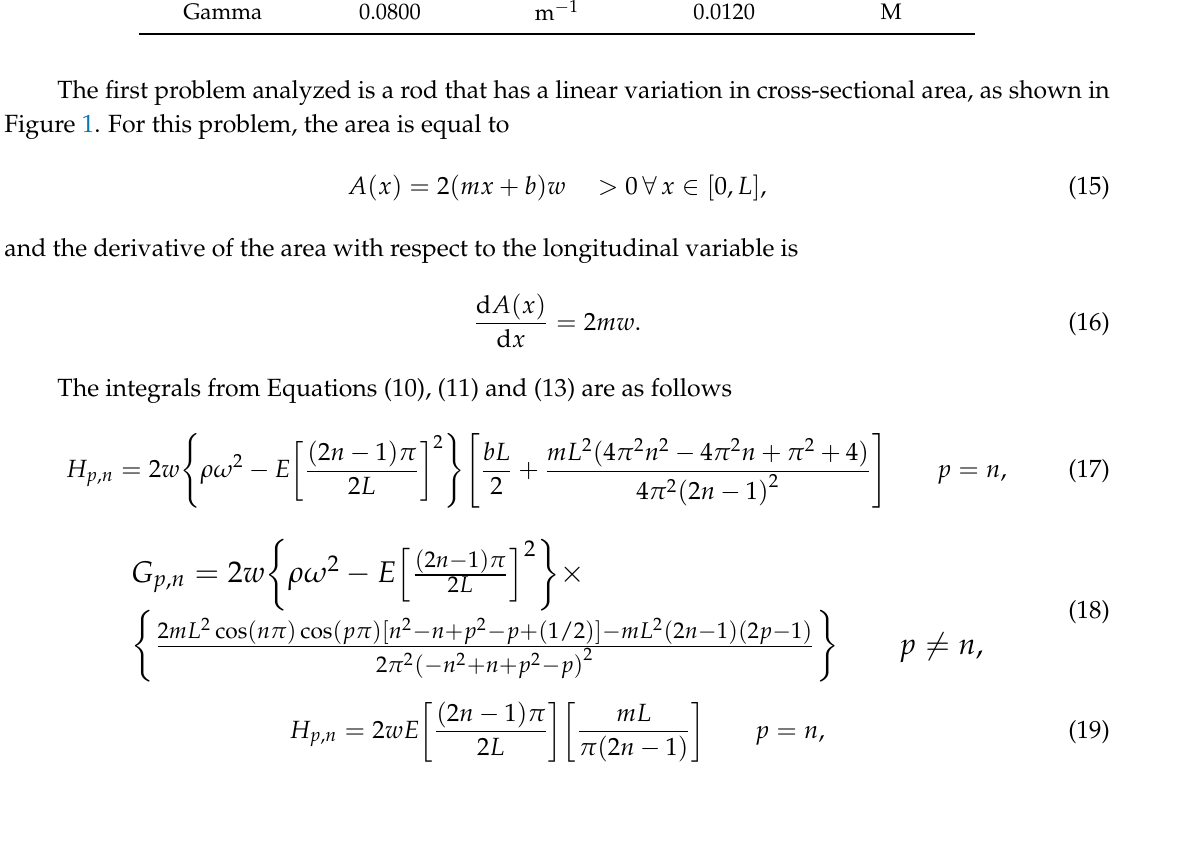
Table 1. Values of the geometric parameters for specific rod shapes. Rod Shape m Units of m b Units of b Linear − 0.0080 dimensionless 0.0300 M Triangular 0.0040 m 0.0280 Bessel